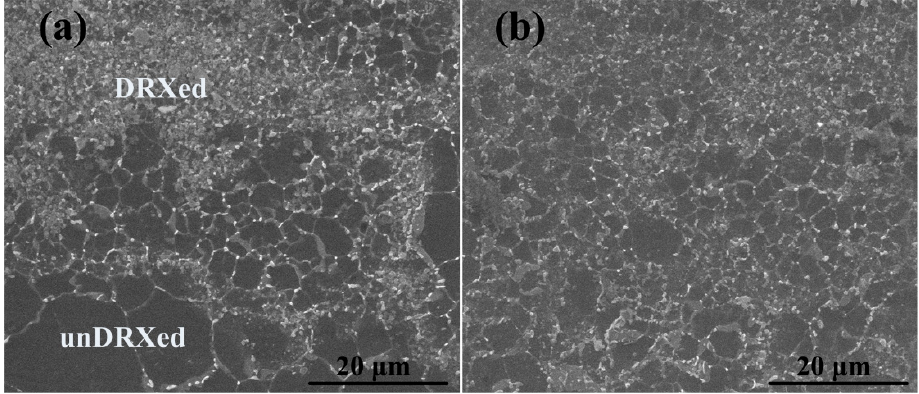
Figure 3. SEM microstructures of the: ( a ) extruded AT81; and ( b ) 0.5 vol % n-SiC p /AT81 composites reinforced by 1073 K/2 h treated n-SiC p .